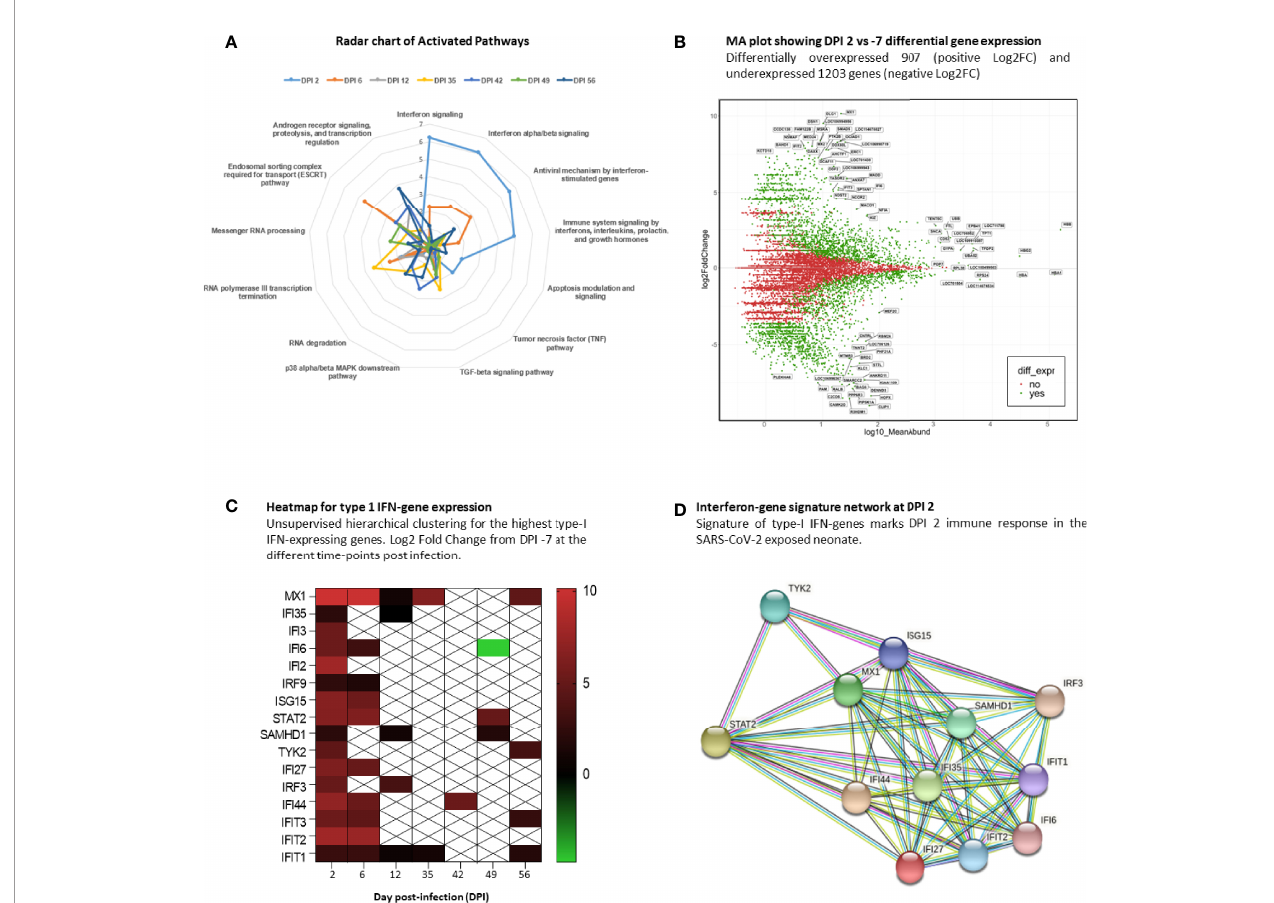
FIGURE 4 | Interferon signature at DPI 2. RNA-sequencing analysis of neonate whole blood. (A) Radar chart of upregulated genes at the infected time points and their associated activation pathways. (B) MA plot of DPI 2 showing 2,110 differentially expressed genes in green, with 907 upregulated and 1,203 downregulated genes. (C) Heatmap showing the gene-expression level of type-I IFN signature genes at different time points. White crossed rectangles are for no gene-expression changes between corresponding time points. (D) The STRING network inference for type-I IFN-associated genes at